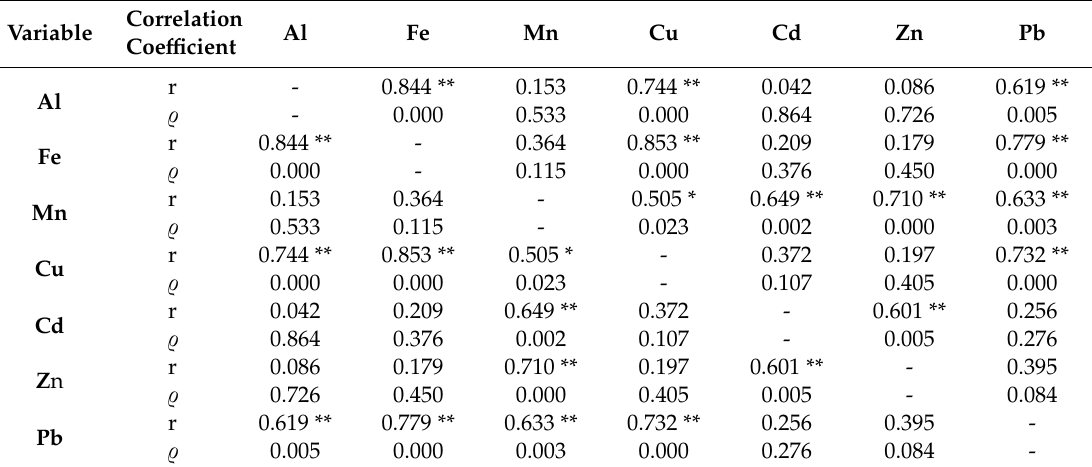
Table A2. Spearman correlation coe ffi cient (r) of particulate elements (w / w) in the > 8 µ m fraction of particulates and significance level ( (cid:37) )